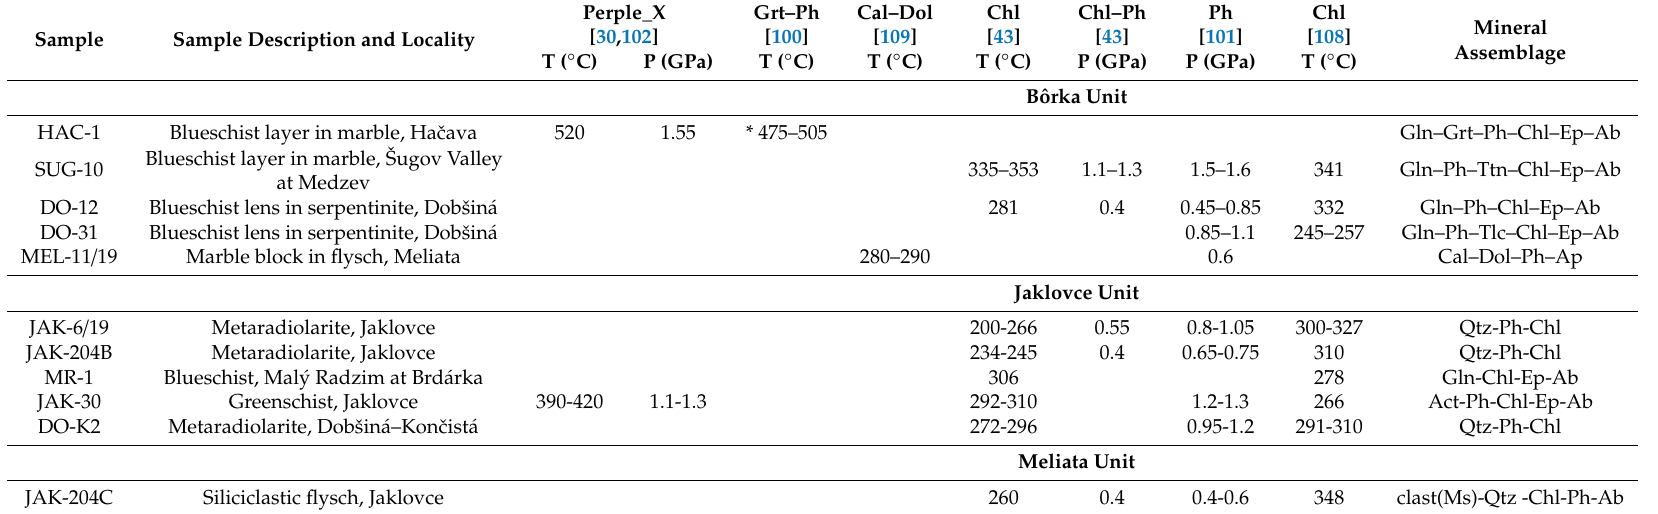
Table 14. Review of P–T estimates from the Meliatic units used in reconstructing the P–T paths (Figure